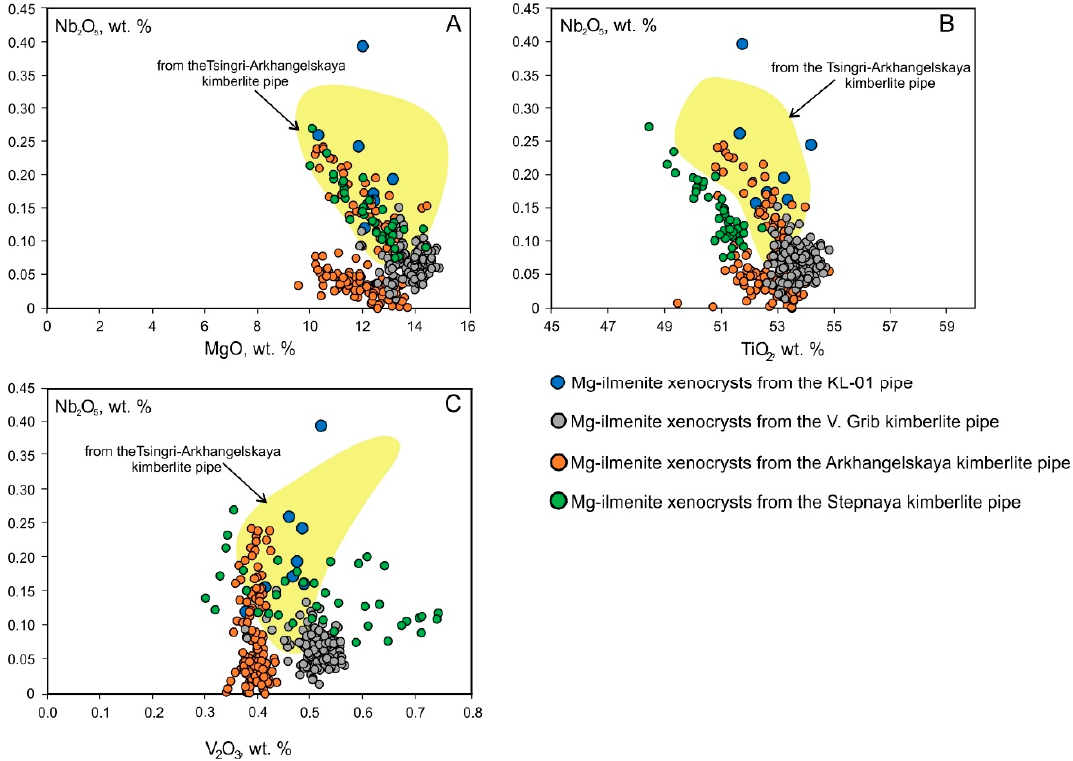
Figure 12. Nb 2 O 5 -MgO ( A ), Nb 2 O 5 -TiO 2 ( B ) and Nb 2 O 5 -V 2 O 3 ( C ) relation diagrams for Mg-ilmenite xenocrysts from the KL-01 pipe. Mg-ilmenite xenocrysts from the Arkhangelskaya pipe [16]; from Stepnaya kimberlite pipe [44]; from the Tsnigri-Arkhangelskaya and V. Grib kimberlite pipes (Tables 5-2 and 5-3 in Supplementary Material).